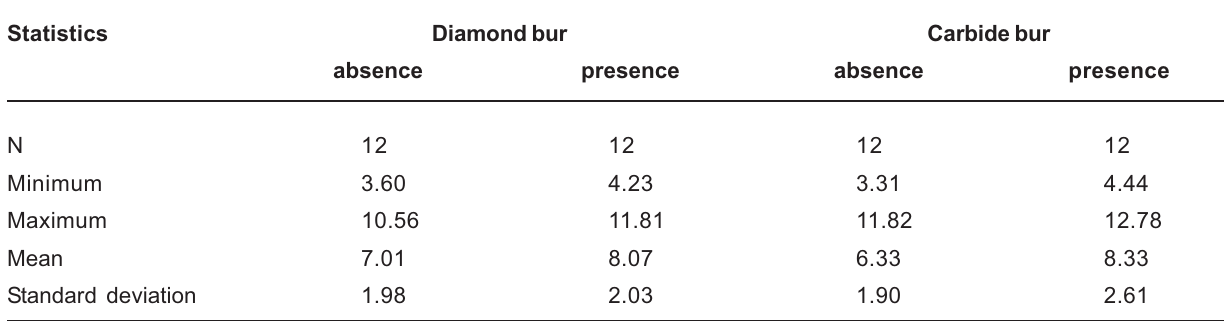
TABLE 1- Descriptive statistics for shear bond strength data (MPa) obtained by type of instrument (diamond and carbide) and acid etching (presence and absence)